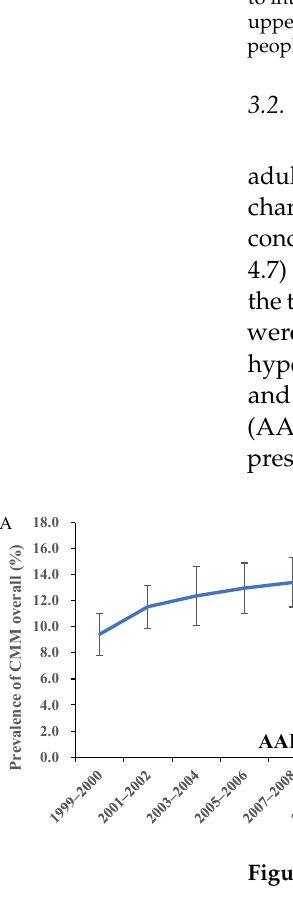
Figure 1. Trends in the age-adjusted prevalence of cardiometabolic multimorbidity and specific pat- terns among U.S. adults, 1999–2018. Notes: The AAPC was derived from joinpoint regression mod- els to assess the averaged trends in the prevalence of comorbidity. Panel A: For CMM overall; Panel B: For two concurrent cardiometabolic diseases; Panel C: For ≥ three concurrent cardiometabolic dis- eases; Panel D: For CMM pattern, HTN, and DM; Panel E: For CMM pattern, HTN, CHD, and DM; Panel F: For CMM pattern, HTN, and CHD. CMM, cardiometabolic multimorbidity; HTN, hyper- tension; DM, diabetes mellitus; CHD, coronary heart disease; AAPC, averaged two-year cycle per- centage change. * p for trend <0.05. When stratified by gender, the prevalence of cardiometabolic multimorbidity overall in both genders increased, while that of two diseases increased significantly for females (AAPC: 3.9, 95% CI: 1.5 to 6.4), and ≥ three conditions increased for males (AAPC: 5.7, 95% CI: 2.2 to 9.3) (Figure 2A–C). In most age groups except for 60–79 years, the prevalence of cardiometabolic multimorbidity overall increased steadily (Figure 2D). For two condi- tions (Figure 2E), the prevalence in people aged 40–59 and ≥ 80 years increased signifi- cantly (AAPC: 6.2 (95% CI: 3.1 to 9.5) for 40–59 years; 2.6 (95% CI: 0.1 to 5.1) for ≥ 80 years). Notably, the prevalence of ≥ three conditions (Figure 2F) in the population aged 80 years and older nearly tripled from 4.1% in 1999–2000 to 13.1% in 2017–2008, with an AAPC of 9.4 (95% CI: 1.6 to 17.9). The trend in the non-Hispanic White population was increasing significantly (AAPC: 3.7, 95% CI: 2.4 to 5.1 for cardiometabolic multimorbidity overall),